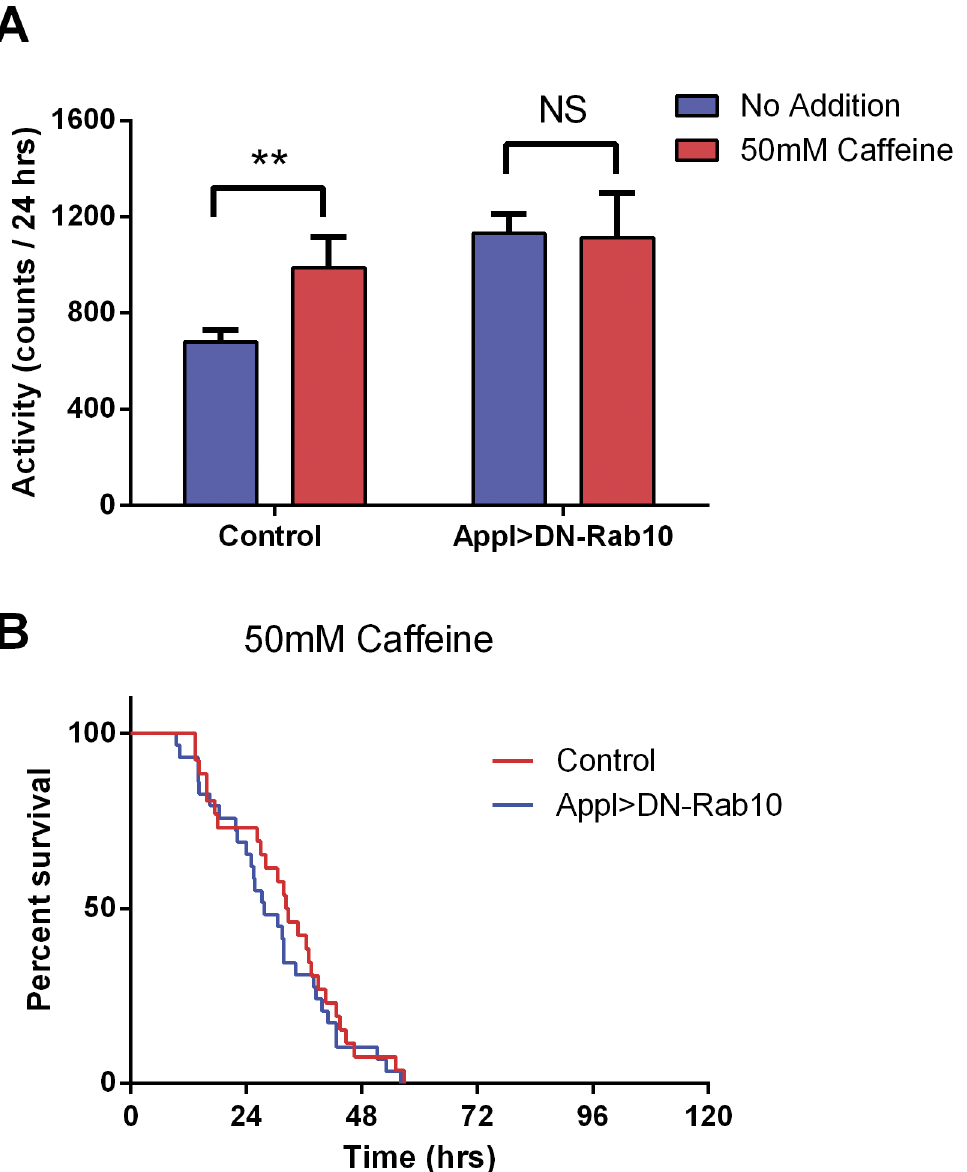
Fig 6. DN-Rab10 inhibits caffeine induced increased activity but not mortality. (A) Activity. Flies were fed food containing 50 mM caffeine and their activity monitored with the same procedure as methamphetamine treatment. Control flies showed an increased activity in the presence of caffeine, whereas flies expressing DN-Rab10 in all neurons showed no increase. Two-way ANOVA: F (1, 74) = 7.32, p < 0.01 for caffeine and F (1,74) = 1.87, p > 0.058 for genotype. Sidak's multiple comparisons test: * p < 0.05, t = 2.309 for control flies and p > 0.05, t = 0.103 for flies expressing DN-Rab10 in all neurons. (B) Mortality. The mean survival time was 33 hours for control flies and 28 hours for flies expressing DN-Rab10 in all neurons (Appl >